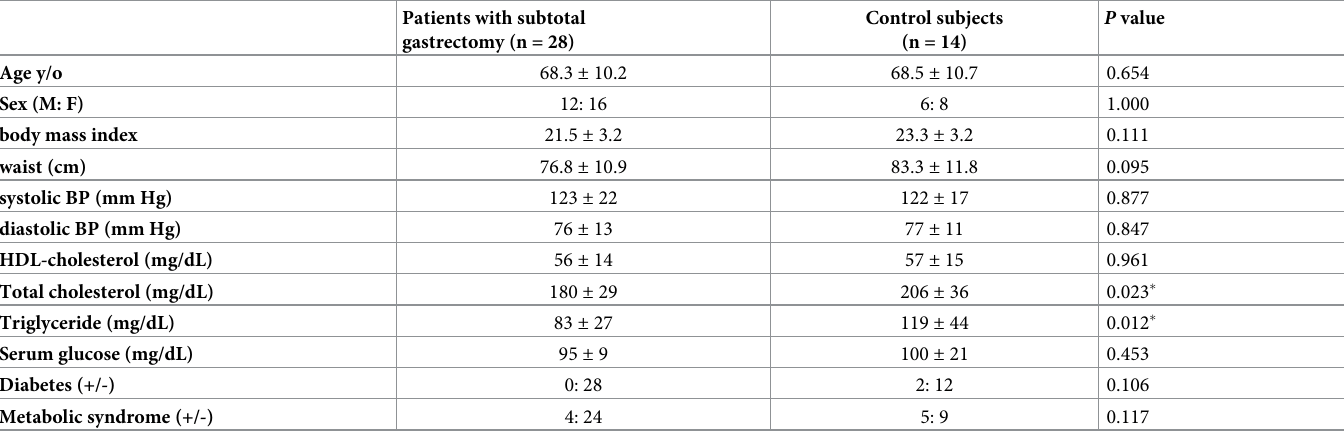
Table 3. Anthropometric and laboratory data between patients (subtotal gastrectomy) and controls with fecal microbiome with a median follow-up of 8.25 years. Patients with subtotal gastrectomy (n =